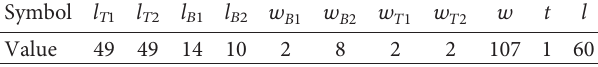
Table 1: Dimension of the TLET-type flexure hinge (unit: